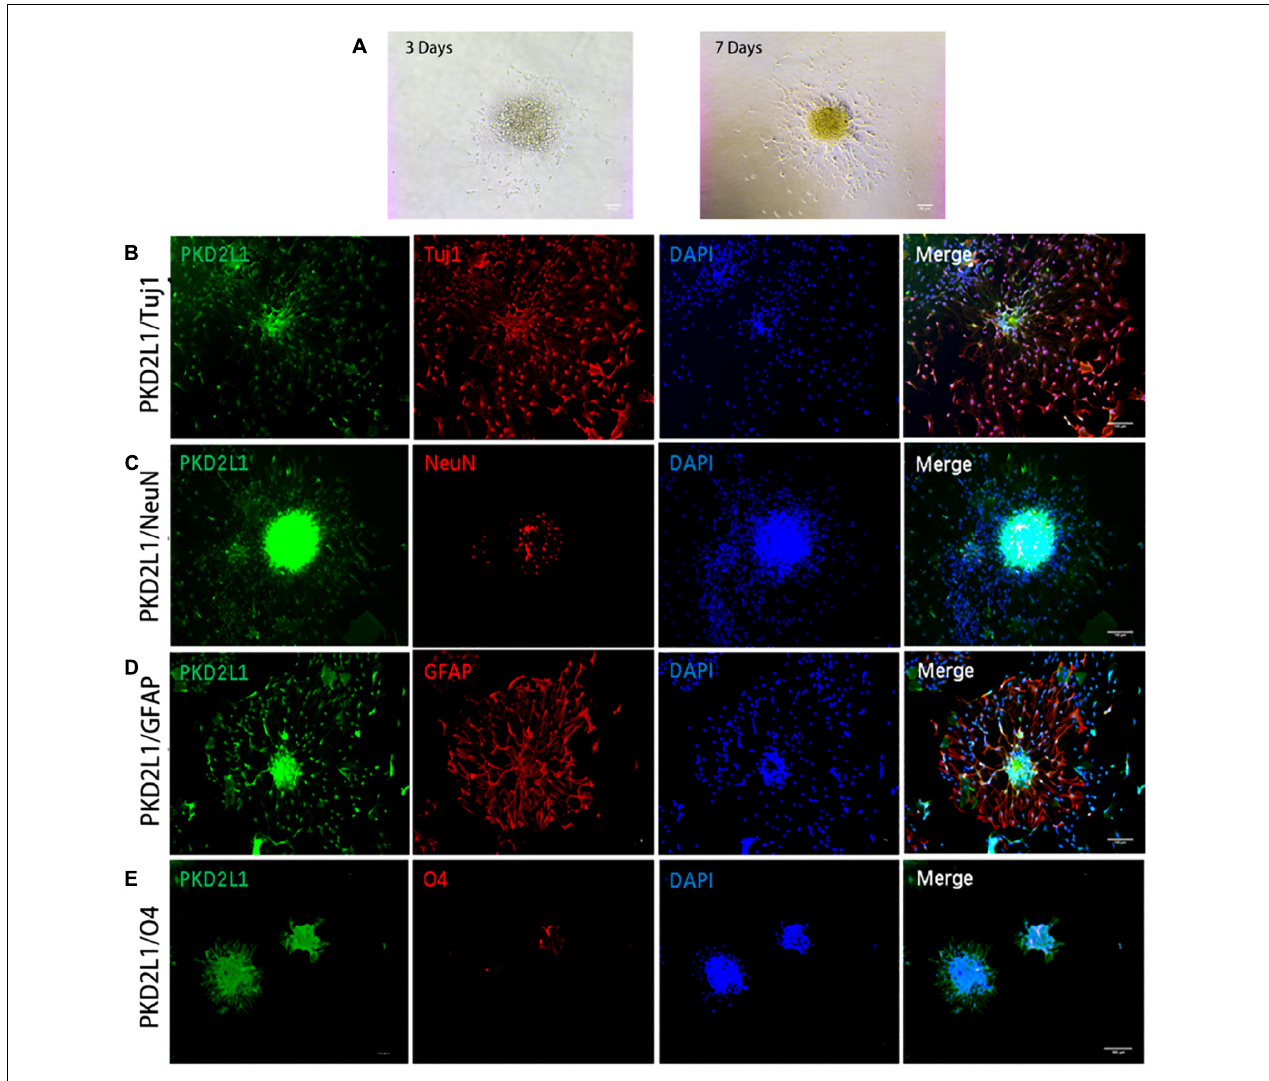
FIGURE 5 | Neurospheres formed by CSF-cNs were tri-potent. (A) Differentiation of neurospheres after adherent culture on days 3 and 7. (B–E) Immunofluorescence analysis showing that neurospheres differentiated into neurons that were positive for Tuj1 (B) and NeuN (C) , astrocytes that were positive for GFAP (D) , and oligodendrocytes that were positive for O4 (E) , respectively. Scale bar represents 50 µ m in (A) and 100 µ m in (B–E)